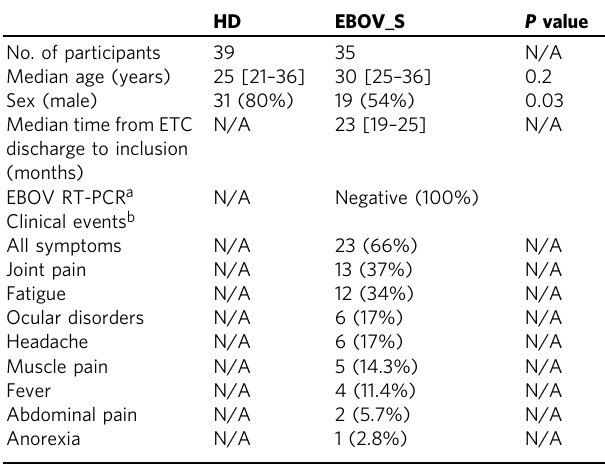
Table 1 Characteristics of survivors and healthy